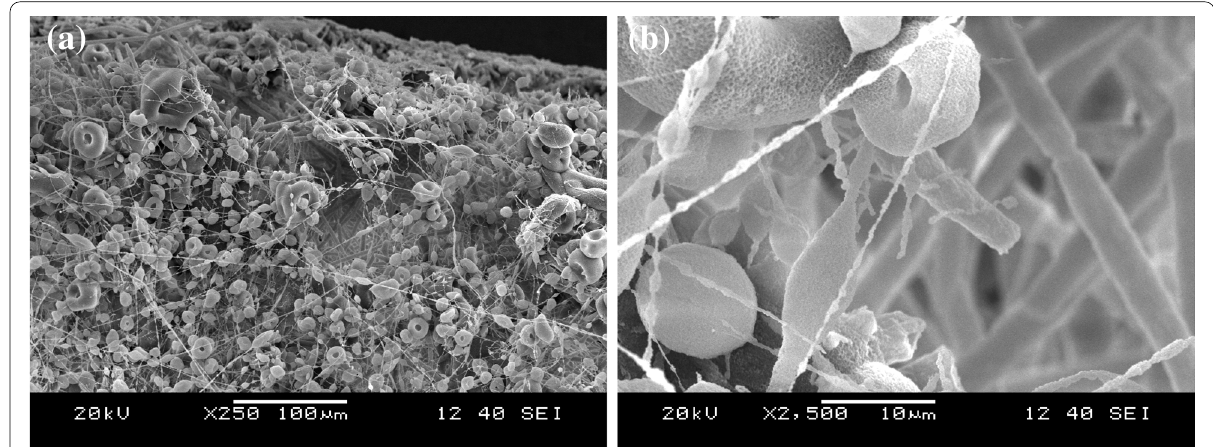
Fig. 3 SEM images of bilayers of SiO 2 incorporated beadless microfibers (3 wt.% SiO 2 ) and beaded nanofibers (1.7 wt.% SiO 2 ) at different magnifications showing micro-nano-fibers within the same sample